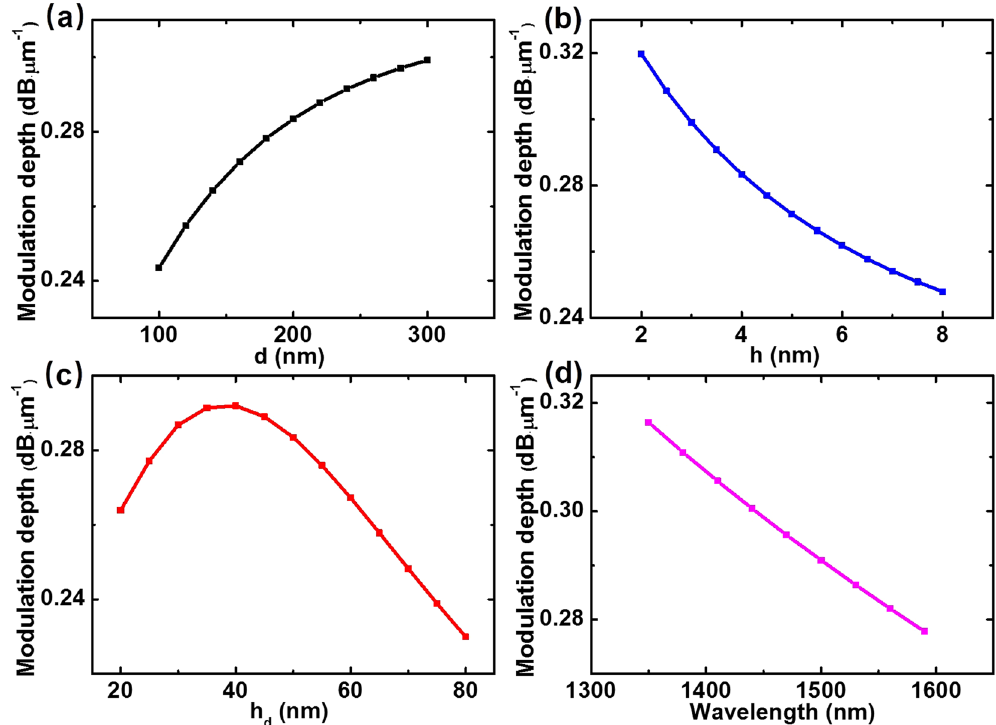
Figure 4. The modulation depth of GHPM varies with the cylinder diameter d, the dielectric gap thickness h and the silicon slab thickness h d , respectively. ( a ) The cylinder diameter d varies from 100 to 300 nm where h = 4 nm and h d = 50 nm. ( b ) The gap thickness h varies from 2 to 8 nm where d = 200 nm and h d = 50 nm. ( c ) The silicon slab thickness h d varies from 20 to 80 nm where d = 200 nm and h = 4 nm. ( d ) The modulation process of GHPM is achieved for a broad band of wavelengths from 1350 nm to 1600